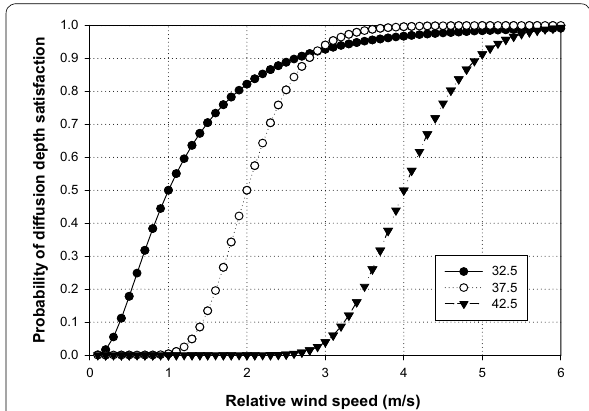
Fig. 9 Satisfaction Curve of wind speed parameter for combine chloride diffusion depth rate (32.5, 37.5, 42.5).